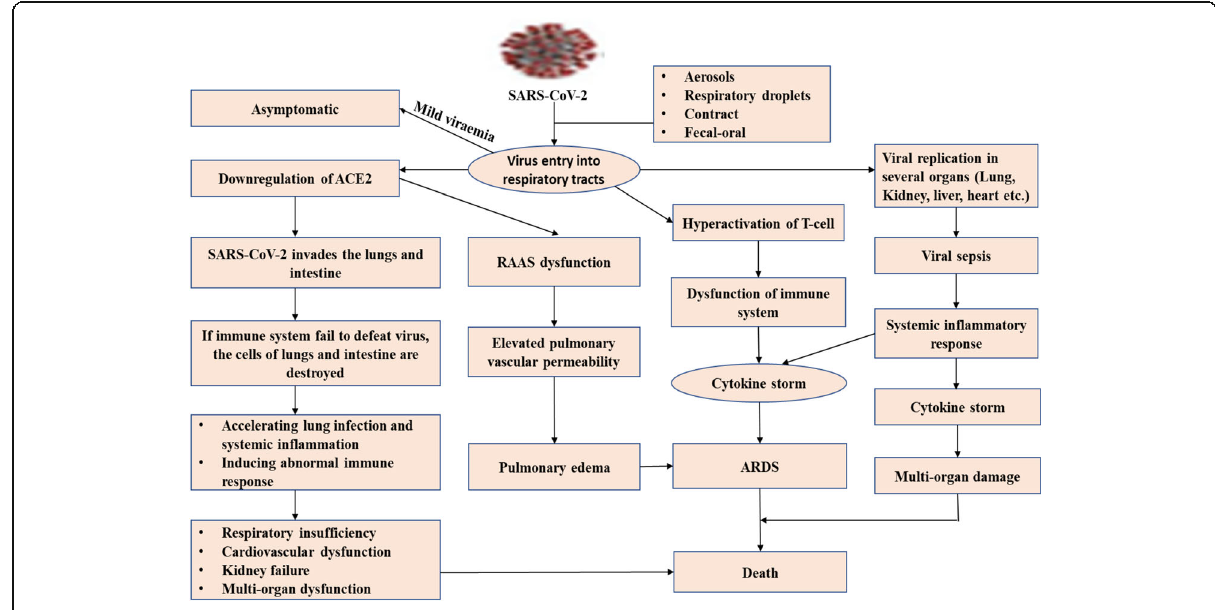
Fig. 1 Hypothesized pathogenesis of SARS-CoV-2 infection SARS-CoV-2, severe acute respiratory syndrome coronavirus 2; ACE2, angiotensin-converting enzyme 2; ARDS, acute respiratory distress syndrome; RAAS, renin-angiotensin-aldosterone